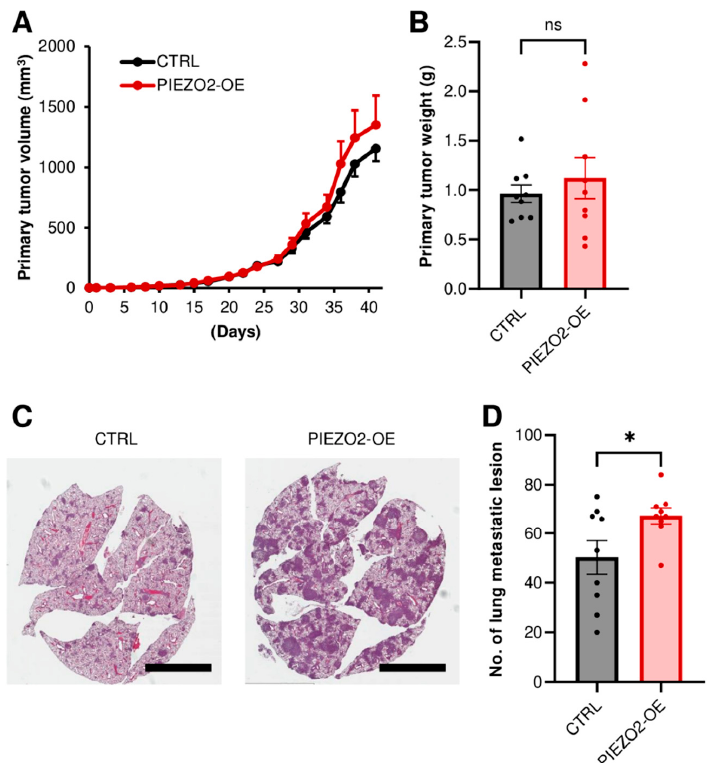
Figure 6. PIEZO2 upregulation increases lung metastasis of TNBC cells. ( A ) Tumor growth curves of control (CTRL) and PIEZO2 overexpressed (PIEZO2-OE) MDA-MB-231 in mice. ( B ) Comparison of primary tumor weight between control and PIEZO2 overexpressed tumors at the endpoint. ( C ) Representative images of lung metastasis. Scale bar indicates 5 mm. ( D ) Comparison of lung macrometastatic lesion numbers in control and PIEZO2 overexpressed groups. n = 9, each. * p < 0.05.